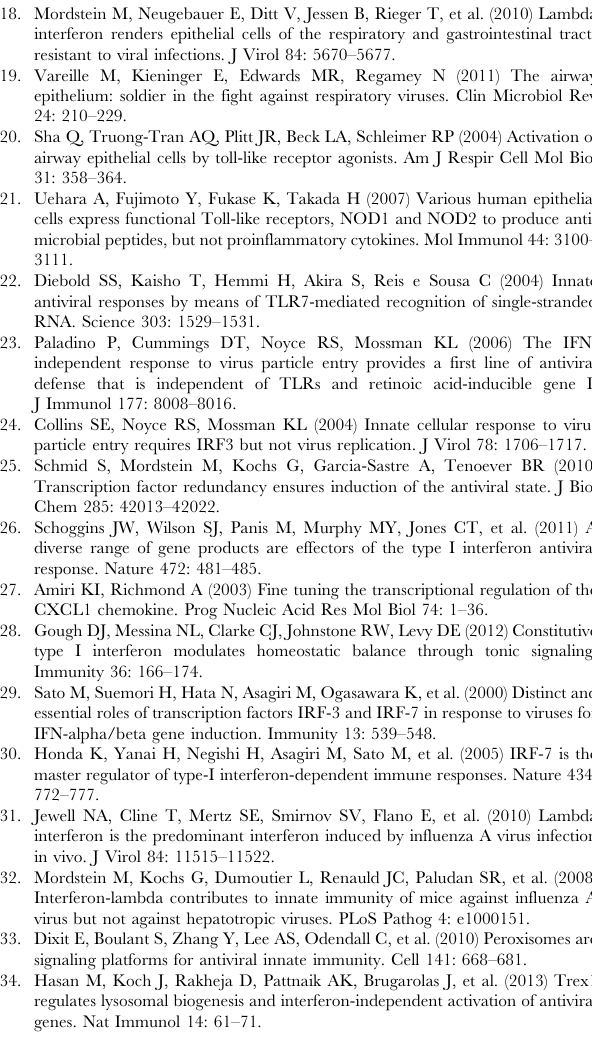
infected wt; 2-way ANOVA, p , 0.01, Benjamini-Hochberg multi- ple test correction). The upregulated genes shown in figure 5A were further partitioned by K-means clustering to generate two clusters of which the one shown in (A) includes the genes that were upregulated upon infection in all genotypes. (B) shows the same cluster as a heat map. The cluster in (C) includes the 110 genes that were upregulated only in wild-type and single knock-out epithelia. 58 genes of the latter list were recognized as ISG by the INTERFEROME database. The range of fold changes is expressed in a log2 scale. Figure S5 Assessment of genes differentially expressed in the absence of either IFN type I or type III. Total RNA from mock and PR8 infected cells was analysed using Affymetrix Mouse Genome 430 2.0 microarrays at 24 hpi. Supervised analysis was performed as in figure 5A, using statistical filtering ( $ 4-fold change relative to mock infected wt; 2-way ANOVA, p , 0.01, Benjamini-Hochberg multiple test correction). The upregulated genes described in figure 5A were further filtered ( $ 4-fold change in expression for corresponding time points for the following pairs of condition: IFNAR1 2 / 2 versus wild-type; IL-28R a 2 / 2 versus wild-type; IL- 28R a 2 / 2 versus IFNAR1 2 / 2 ) to generate the heat map shown here. (TIF)